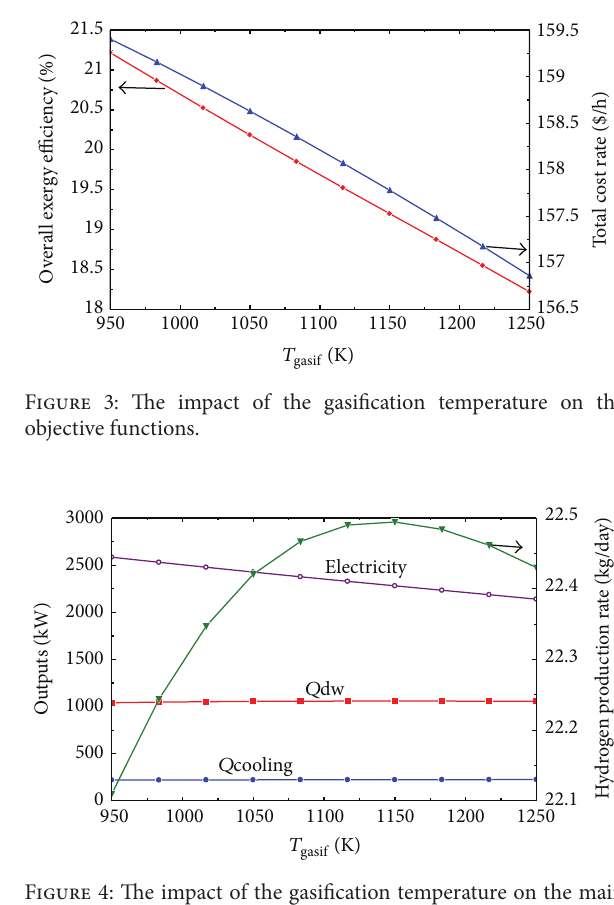
Figure 4: The impact of the gasification temperature on the main outputs. 𝑄 dw: domestic water heater. 𝑄 cooling: absorption chiller